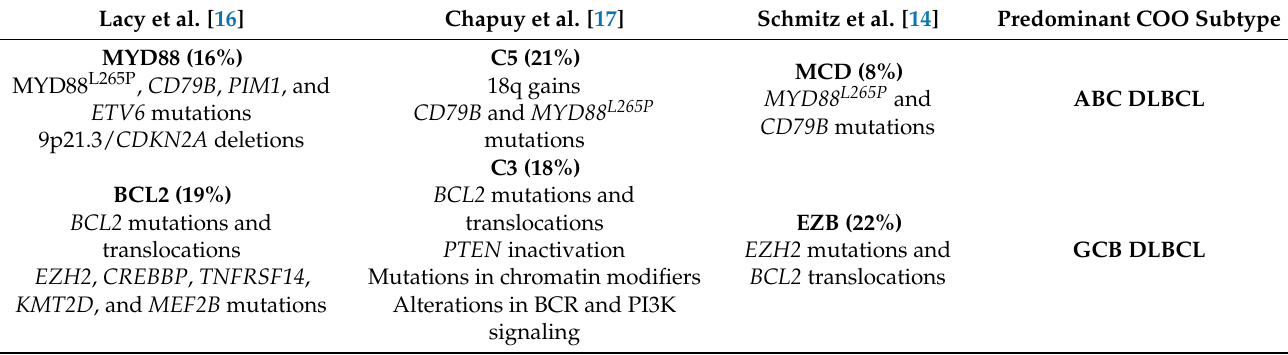
Table 1. Overview of Recently Proposed Genetic Classifications of